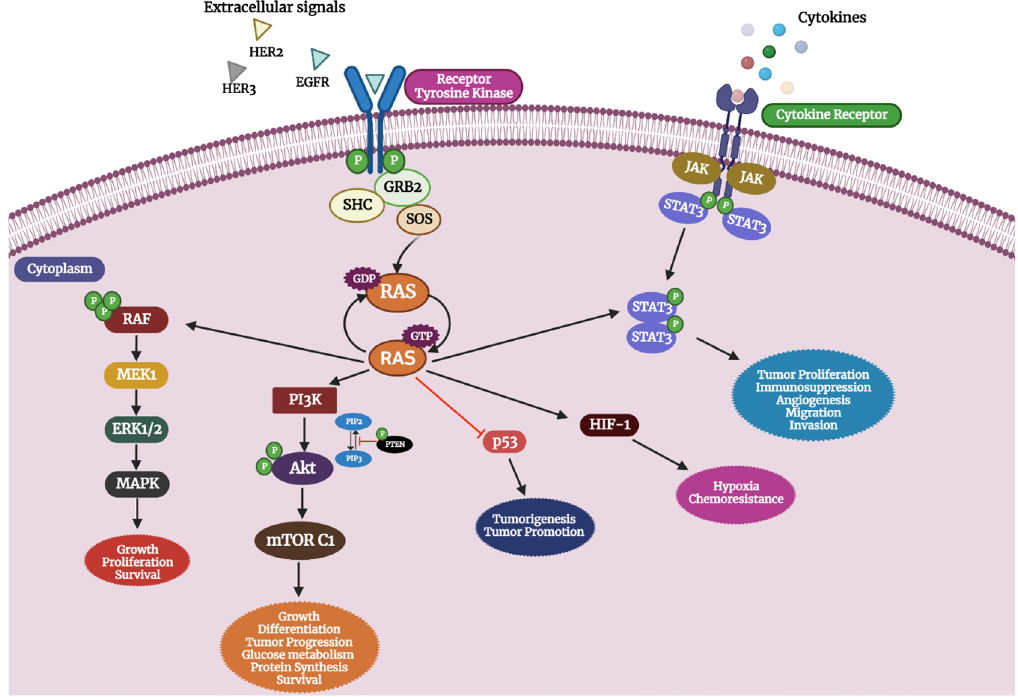
Figure 2. Effect of oncogenic activation of RAS signaling in OC. RAS mutation leads to aberrant activation of the RAS pathway leading to a cluster of other pathway activations involved in tumorigenesis (created with